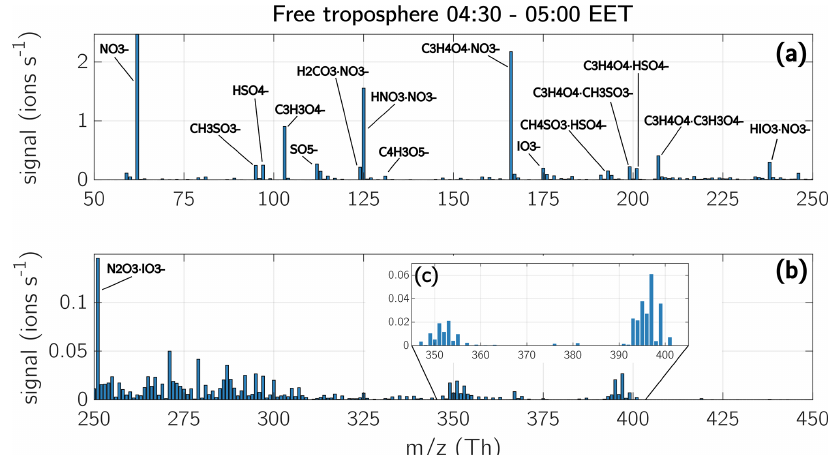
Figure 15. Mass spectra of the free troposphere during early morning. The depicted spectra show a median from six measurements conducted during early morning hours between 04:30–05:00EET in the FT: 2 May (at 3200m), 3 May (2700m), 4 May (2700m), 5 May (2800m), 12 May (2500m), and 16 May 2017 (2600m). The chemical composition of the ions with the highest signal are shown in the spectra. Panel (a) shows the masses from 50–250Th, panel (b) from 250–450Th. Please note that the limits of the vertical axis in panel (b) are lower than in panel (a) , in order to visualize the compounds with a lower concentration. Panel (c) is a close-up of the mass range from 345 to 405Th. The averaged signal shown in panel (c) is mainly coming from two measurement days, 3 May and 12 May 2017. The temperature in the FT at measurement height during all six measurement days was between − 15 and − 2 ◦